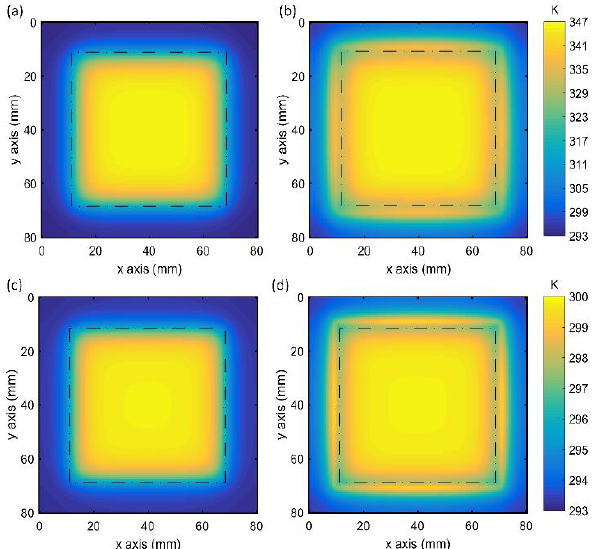
Figure 5. Temperature distributions in the central cross-section of the gain slab ( a ) without and ( b ) with the cladding glass, and those at the surface of the gain slab ( c ) without and ( d ) with the cladding glass. The dotted lines indicate the laser beam areas.